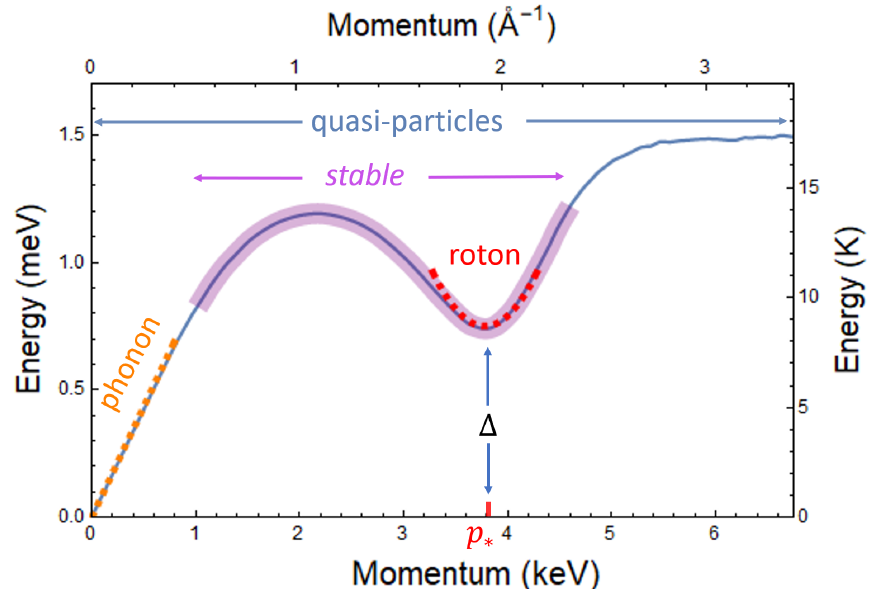
Figure 1 . Dispersion curve for the quasiparticles in superfluid He measured in [53]. The orange dashed line is the linear phonon dispersion E = c corresponds to the roton dispersion eq. (2.4). The deep purple band is the region where quasiparticles are